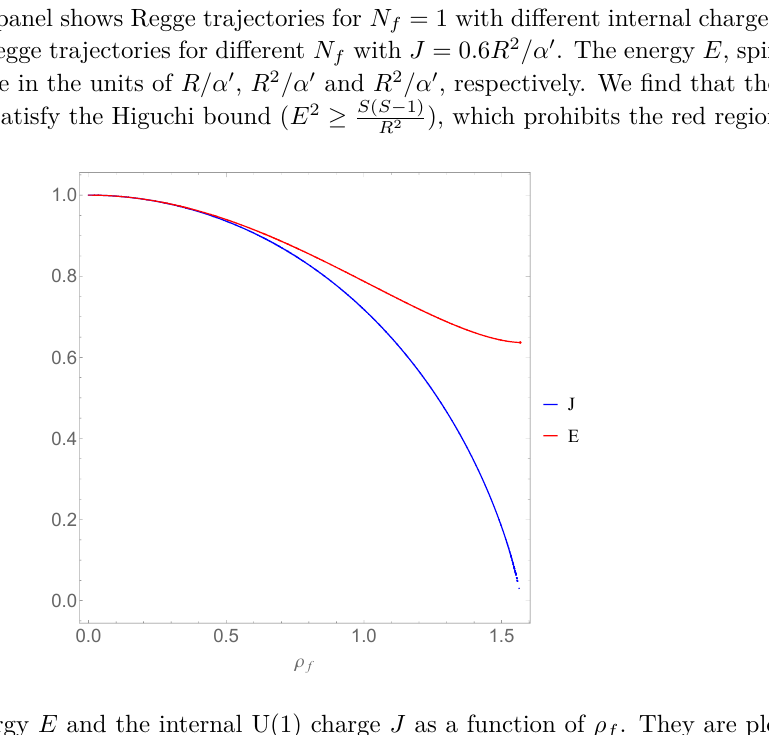
Figure 4 . The energy E and the internal U(1) charge J as a function of ρ f . They are plotted in the units of N 0 and N 2 /α 0 , f R/α f R